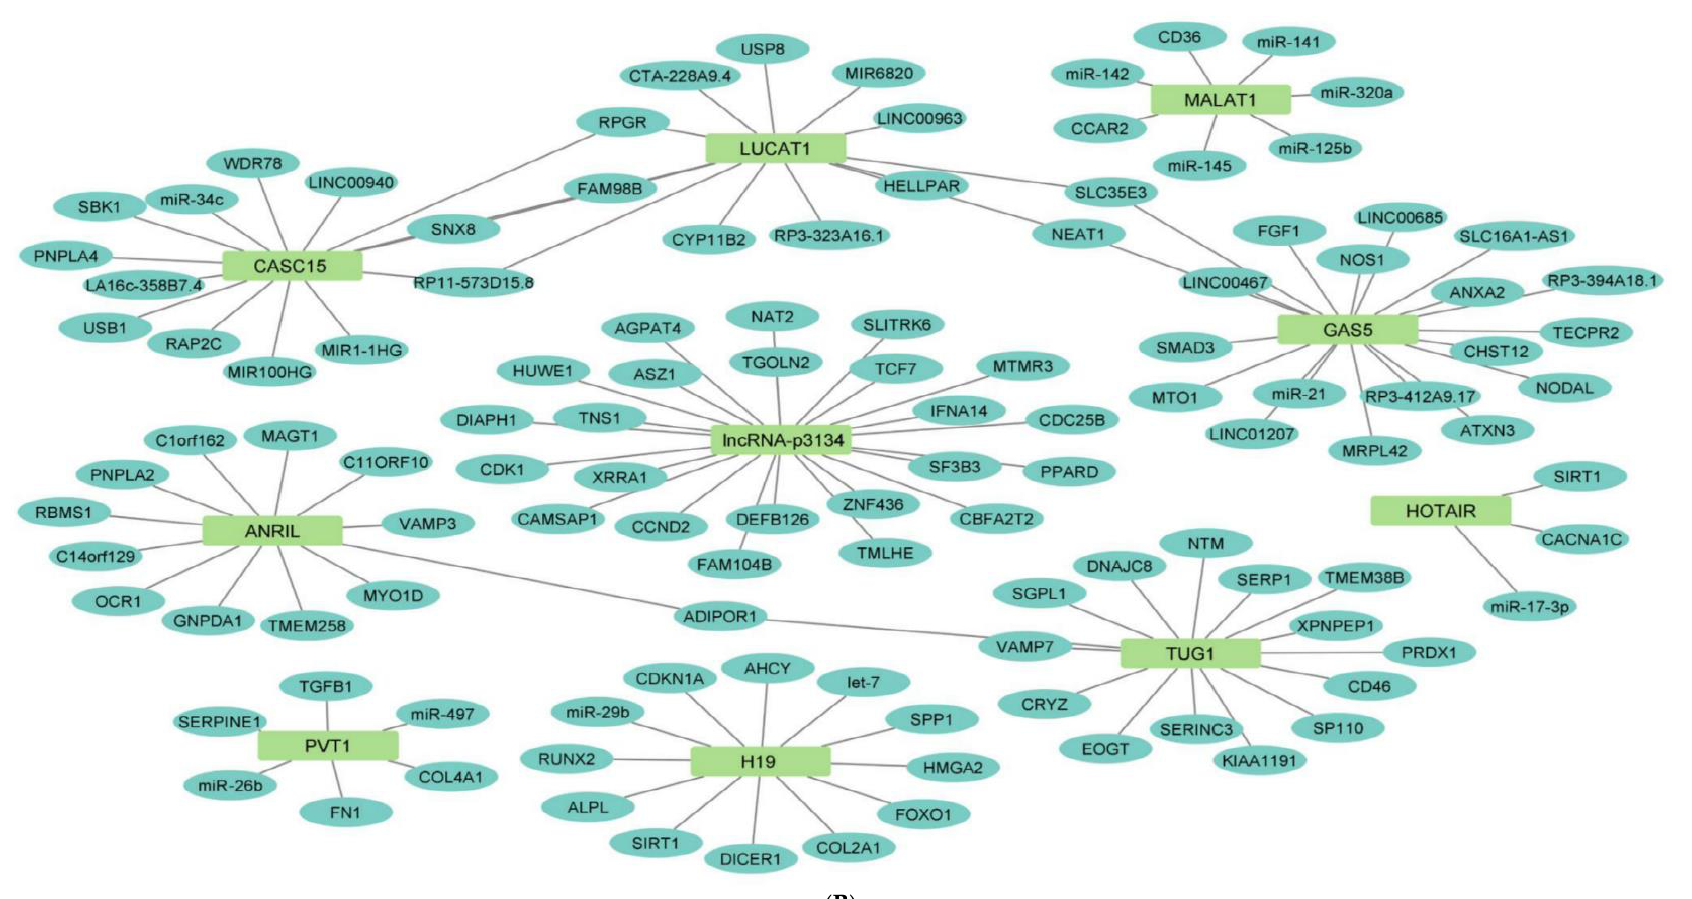
Figure 3. Upregulated human lncRNA networks in diabetes: ( A ) Human lncRNA – lncRNA network: Human lncRNA – lncRNA interaction network with 92 nodes and 4186 edges. The networks were constructed using Cytoscape 3.9.1 [84]. ( B ) Human lncRNA – gene target network: Architecture of networks of upregulated lncRNAs implicated in diabetes in humans showing interaction network of lncRNAs with their targets, with 127 nodes and 124 edges. The networks were constructed using Cytoscape 3.9.1 [84]. The lncRNA – target interactions were identified by lncRNA2target v3.0 [93] and LncRRIsearch [94].